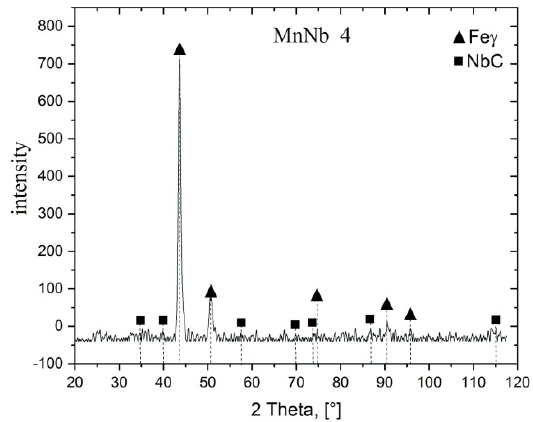
Figure 12. X-ray diffraction pattern of alloy with the addition of 4.5% Nb.